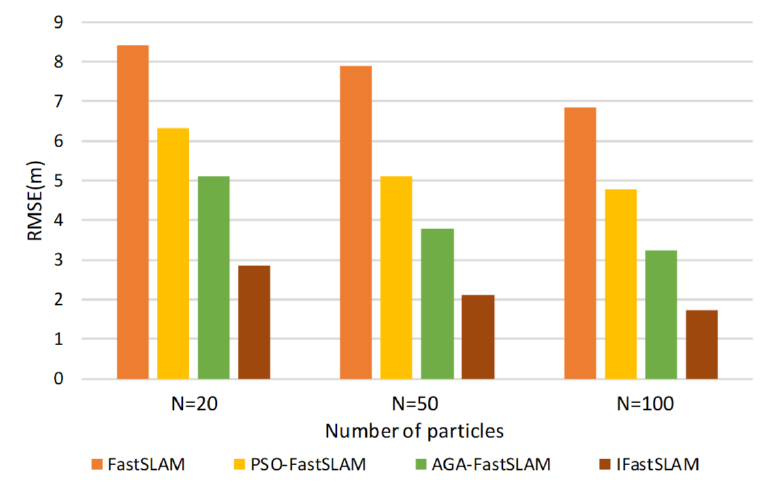
Figure 8. Simulation environment.